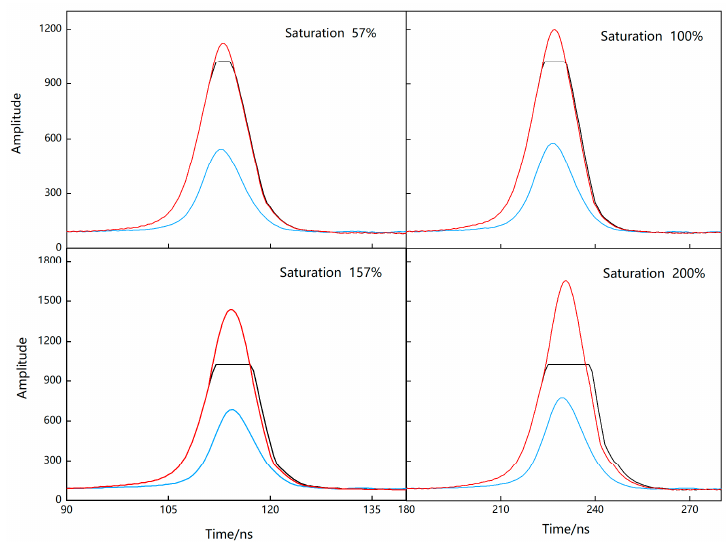
Figure 17. Laser pulse saturation echo compensation results. The black solid line is the high-gain saturated echo, the blue solid line is the low-gain unsaturated echo, and the red solid line is the high-gain echo after saturation compensation.